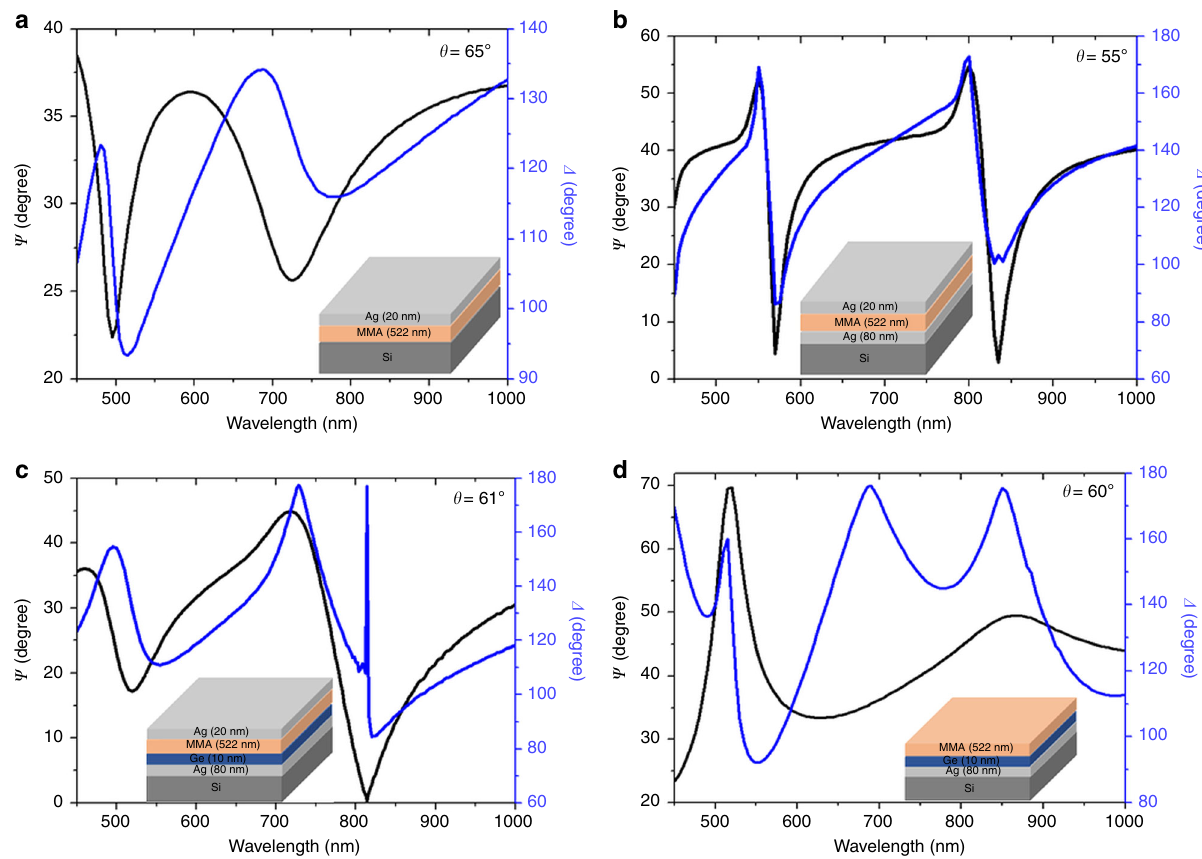
Fig. 1 Experimentally determined ellipsometry parameters ( ψ and Δ ) for a the two-layered system (Ag/MMA), b the three-layered system (Ag/MMA/ Ag), c the proposed four-layered system (Ag/MMA/Ge/Ag), and d in the absence of a top Ag layer (MMA/Ge/Ag). All spectra were plotted for an incident angle at which the minimum ψ was obtained for the longer wavelength mode. All four samples support two cavity